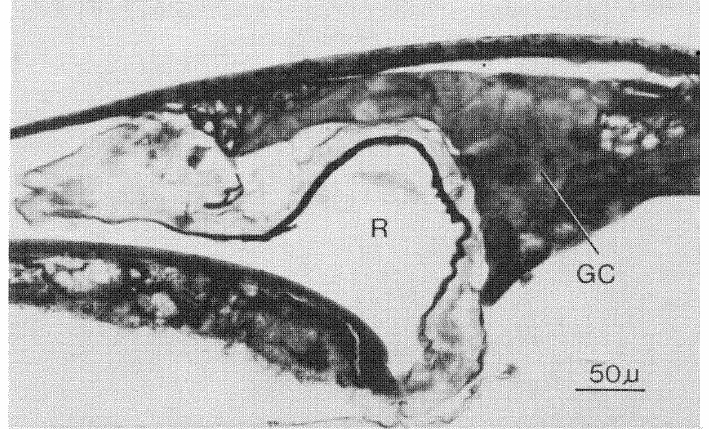
Fig. 3 Longitudinal section through pygidial gland of Pogonomyrmex barbatus GC=glandular cells;